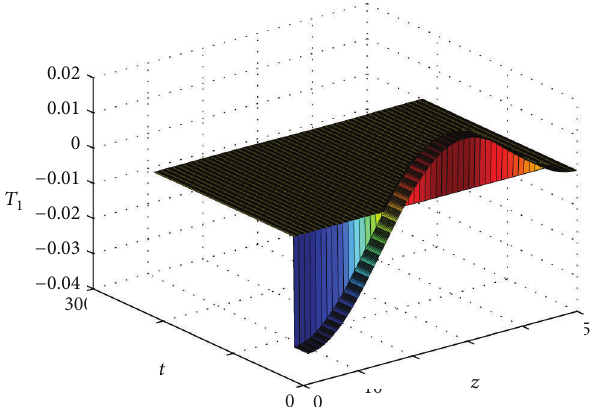
Figure 4: State of the first distributed parameter system under the controller.